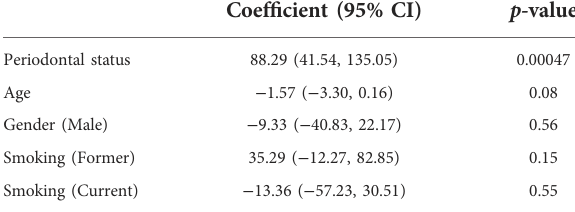
TABLE 3 Multivariate analysis of association between subgingival endotoxin activity and periodontal diagnosis, adjusted for age, gender and smoking